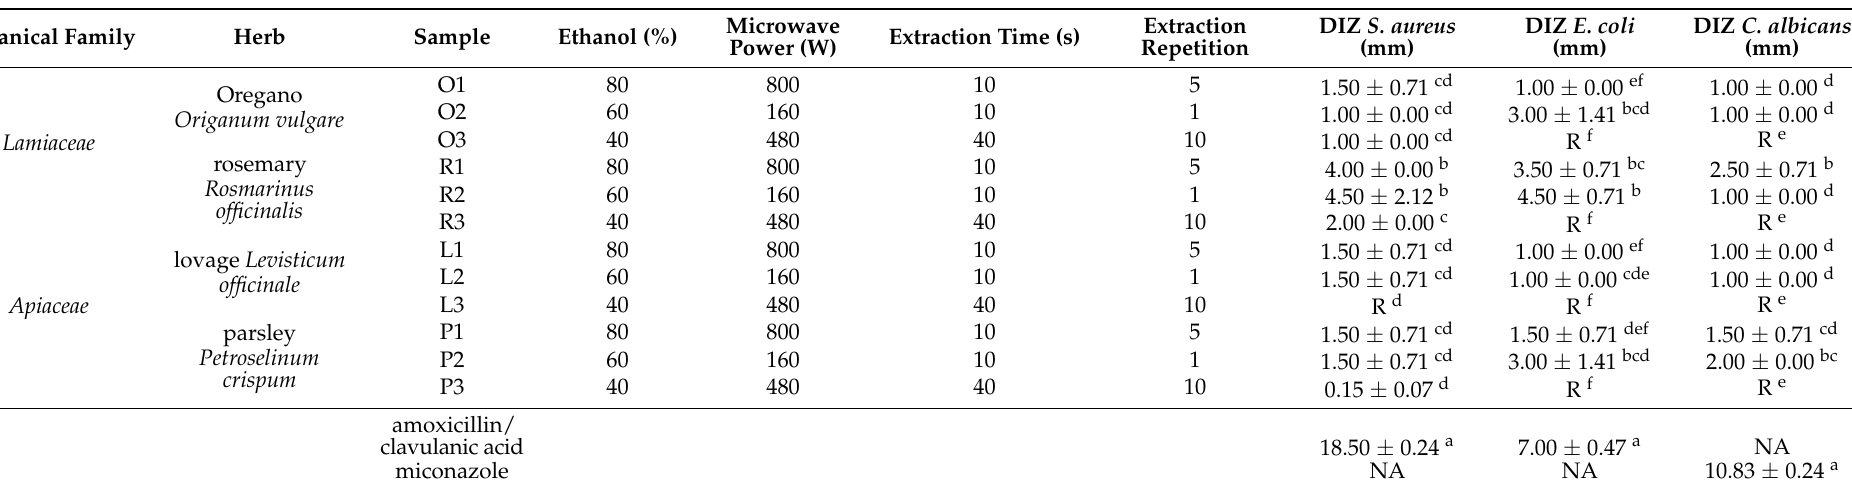
Table 3. Antimicrobial activity of parsley, lovage, rosemary, and oregano extracts against S. aureus , E. coli , and Candida albicans , assessed by the diameter of inhibition zone